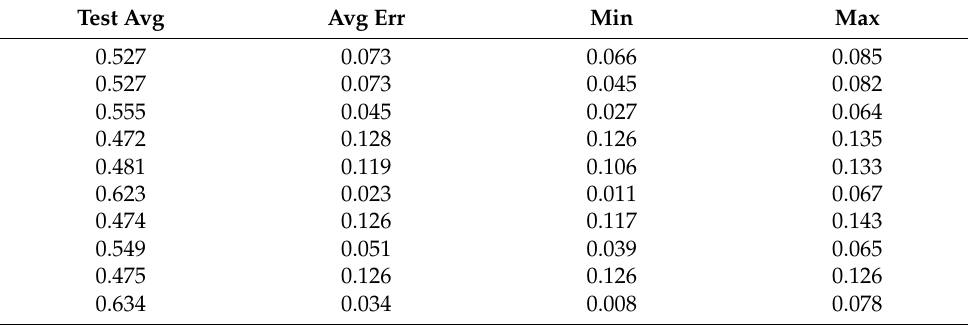
Table A38. Set 1, trials 21–30 data (all 0.5 PR values).